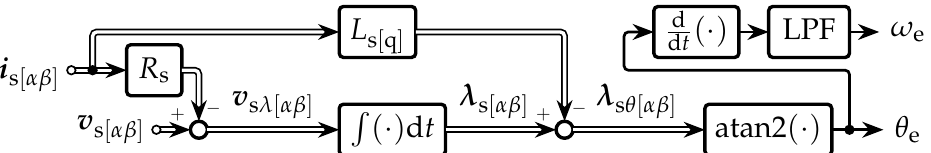
Figure 1. A diagram of the observer proposed for experiments, where ω e is additionally filtered by an